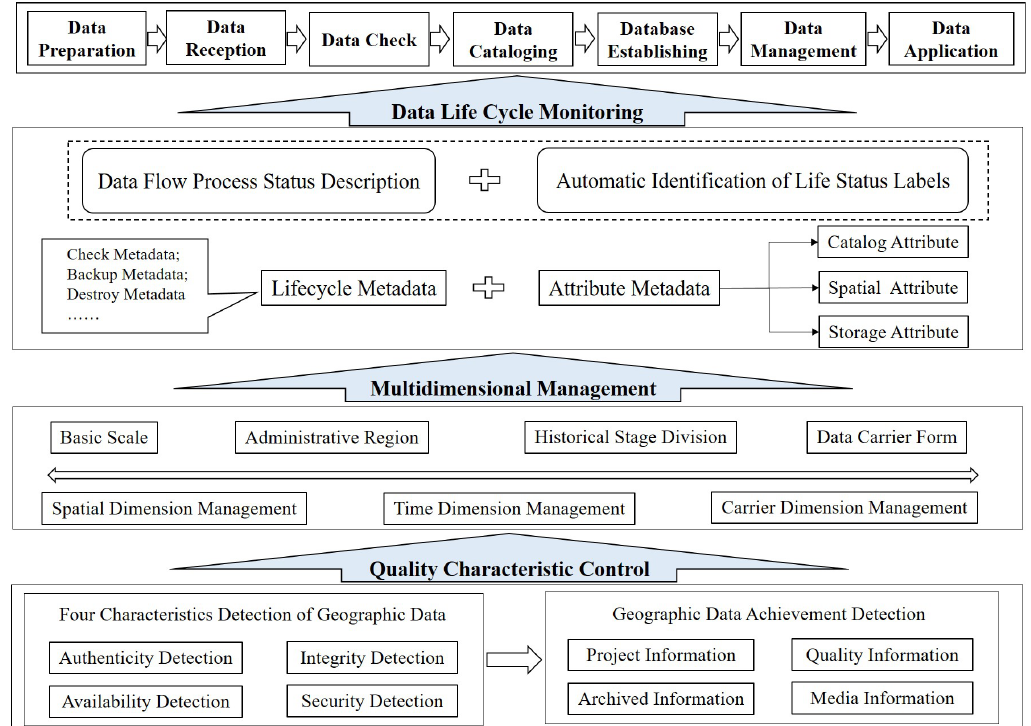
Figure 1 . The technical framework of intelligent governance and application of geographic